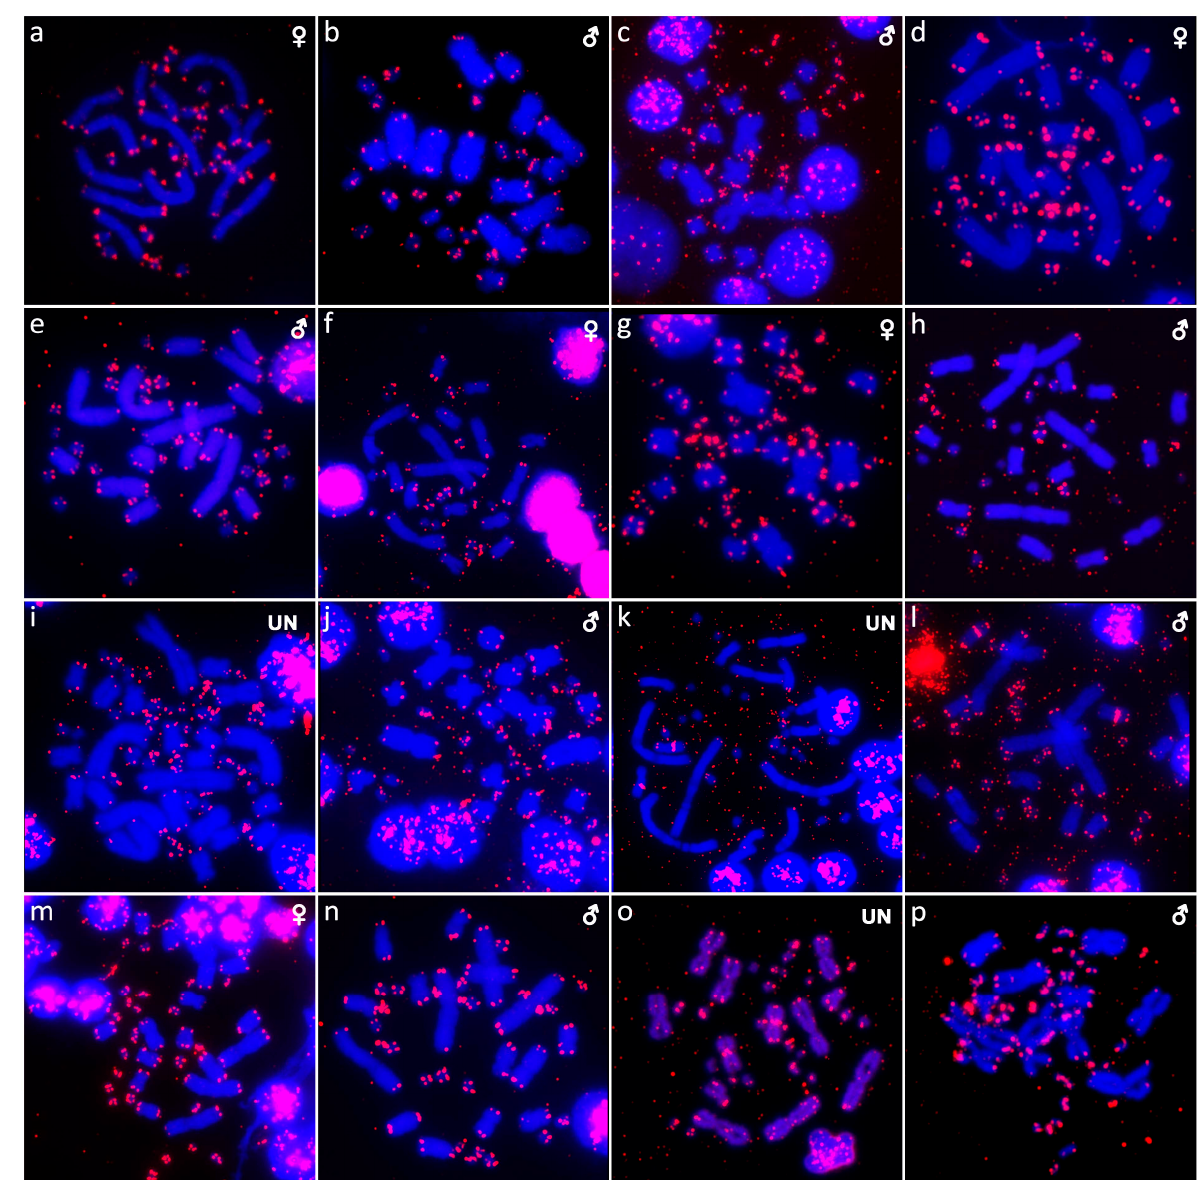
Figure 7. In situ hybridization with probe for telomeric sequences in Shinisaurus crocodilurus ( a , b ), Varanus auffenbergi ( c ), Varanus cumingi ( d , e ), Varanus kordensis ( f ), Varanus primordius ( g , h ), Varanus olivaceus ( i , j ), Varanus salvadorii ( k , l ), Varanus salvator komaini ( m , n ), Xenosaurus platyceps ( o ) and Xenosaurus rectocollaris ( p ). UN: sex not known.